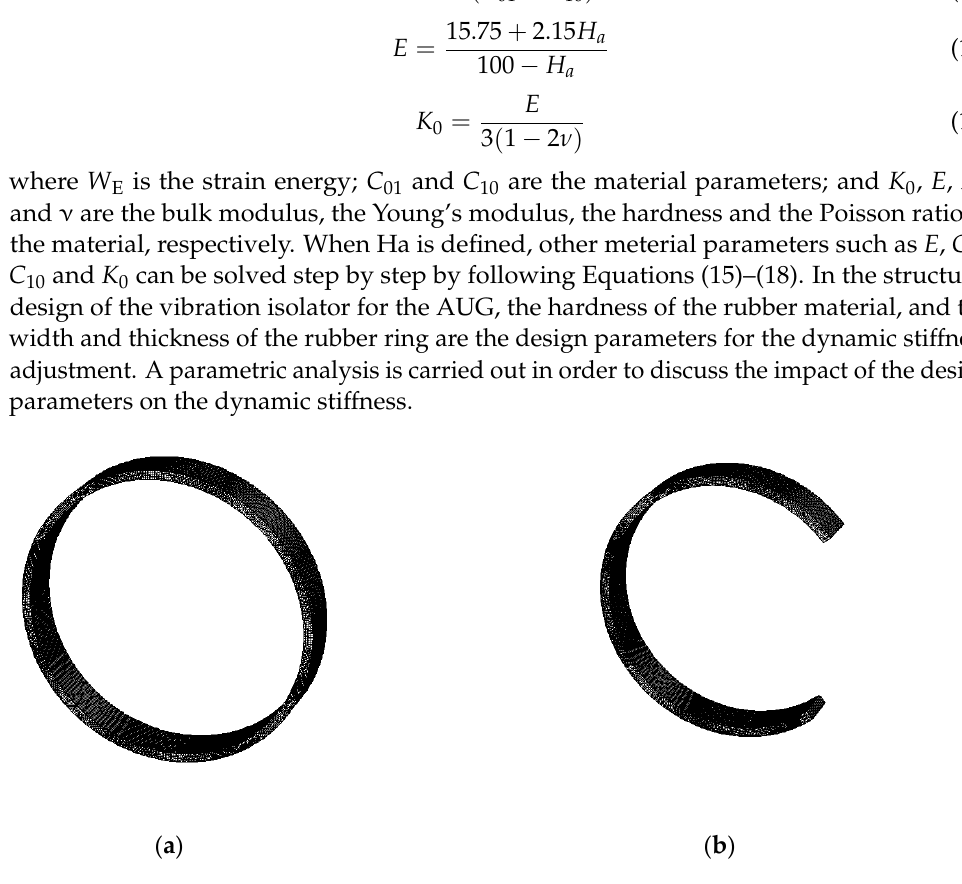
Figure 11. The finite element model meshing of ( a ) the first-stage vibration isolator, and ( b ) the second-stage vibration isolator.